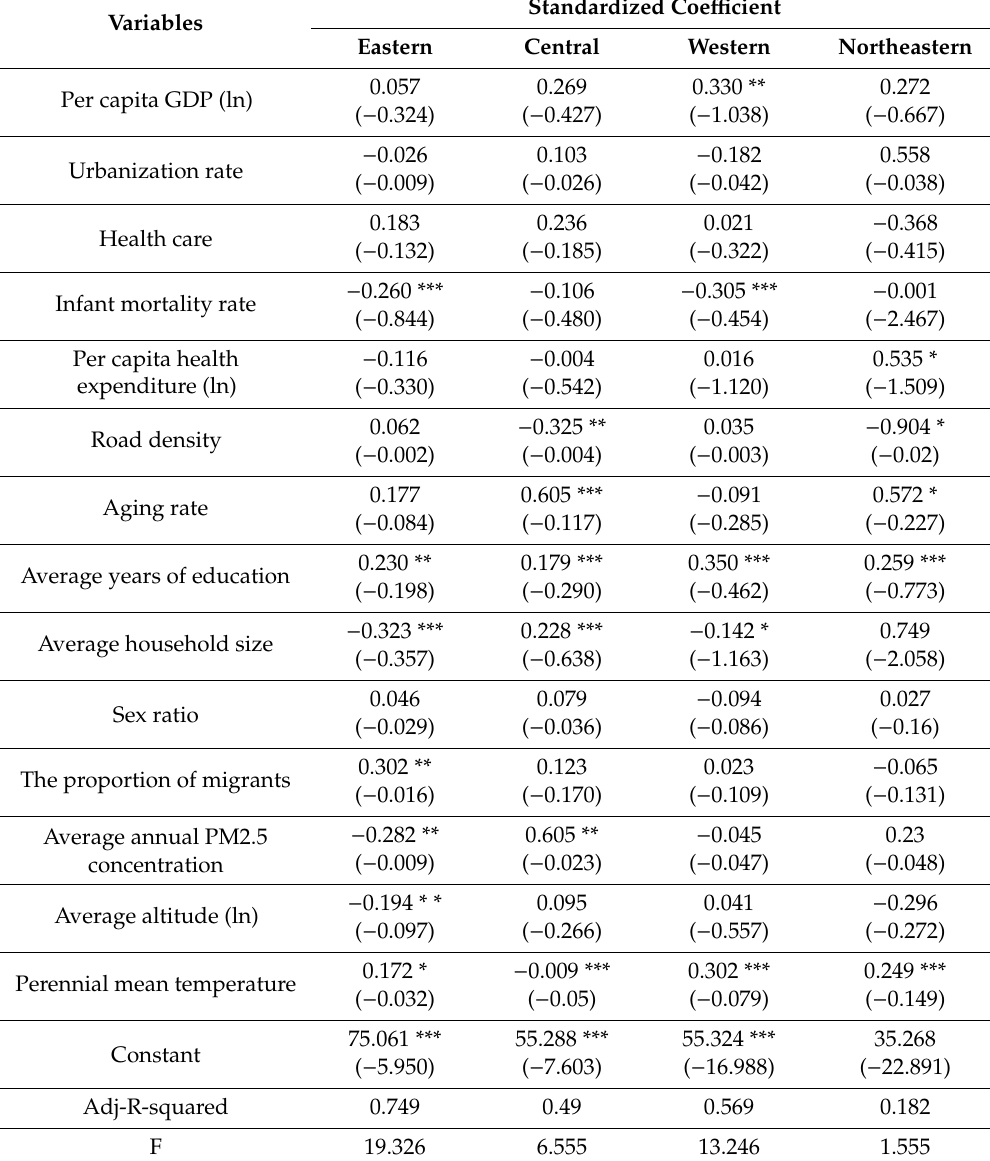
Table 4. Results of OLS regression by